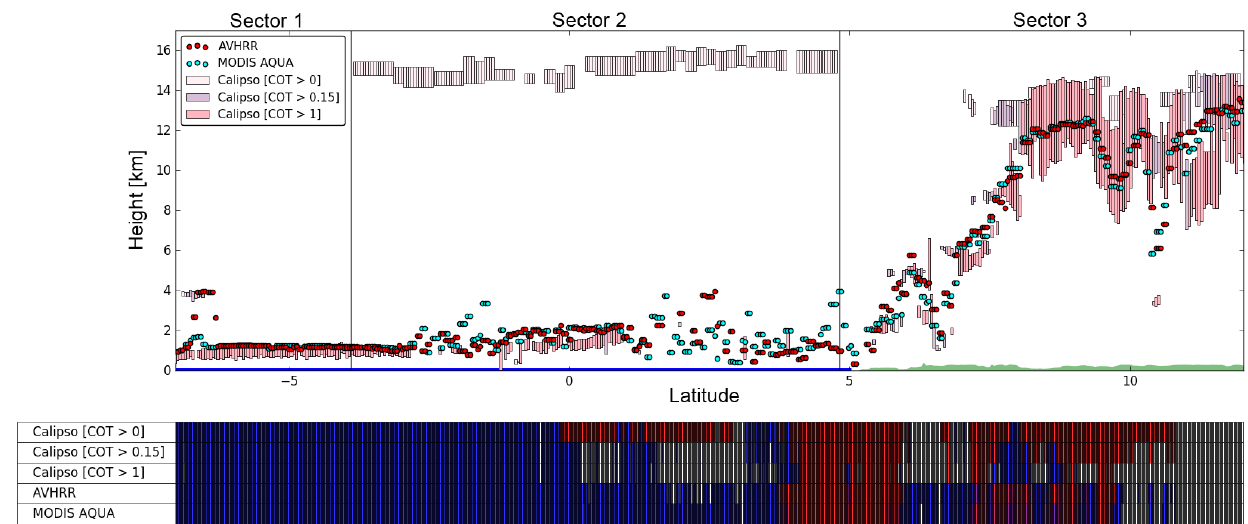
Figure 16. Study area AFR (Africa). As Fig. 10, but on 24 October 2009, 13:45LST. Due to space restrictions, no cloud type values are shown in table. n =